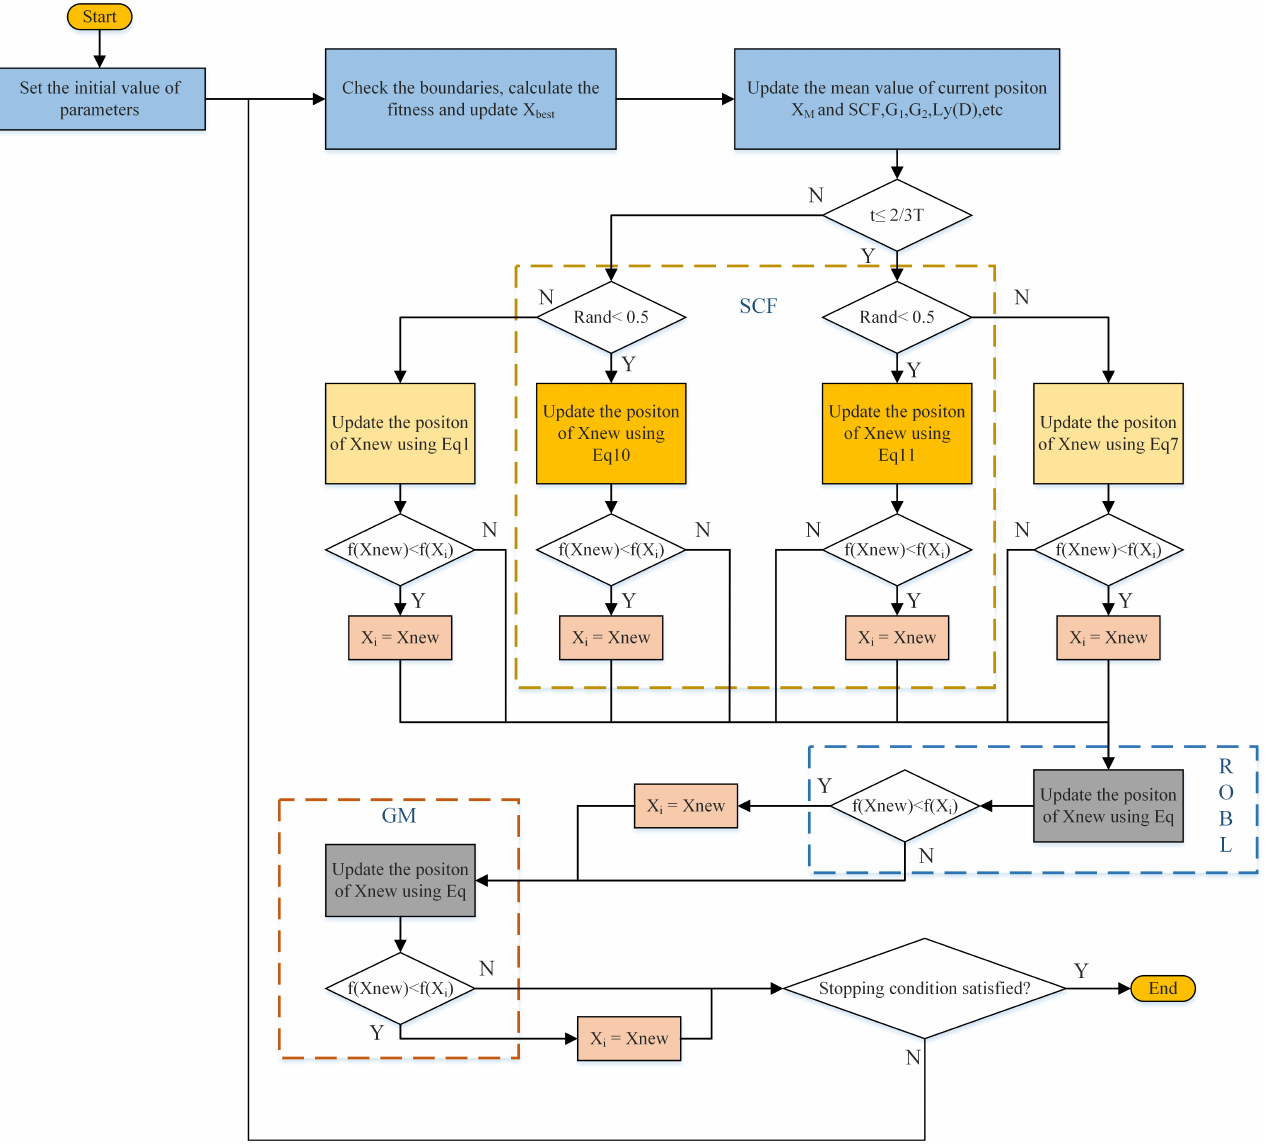
Figure 3. Flowchart of IAO